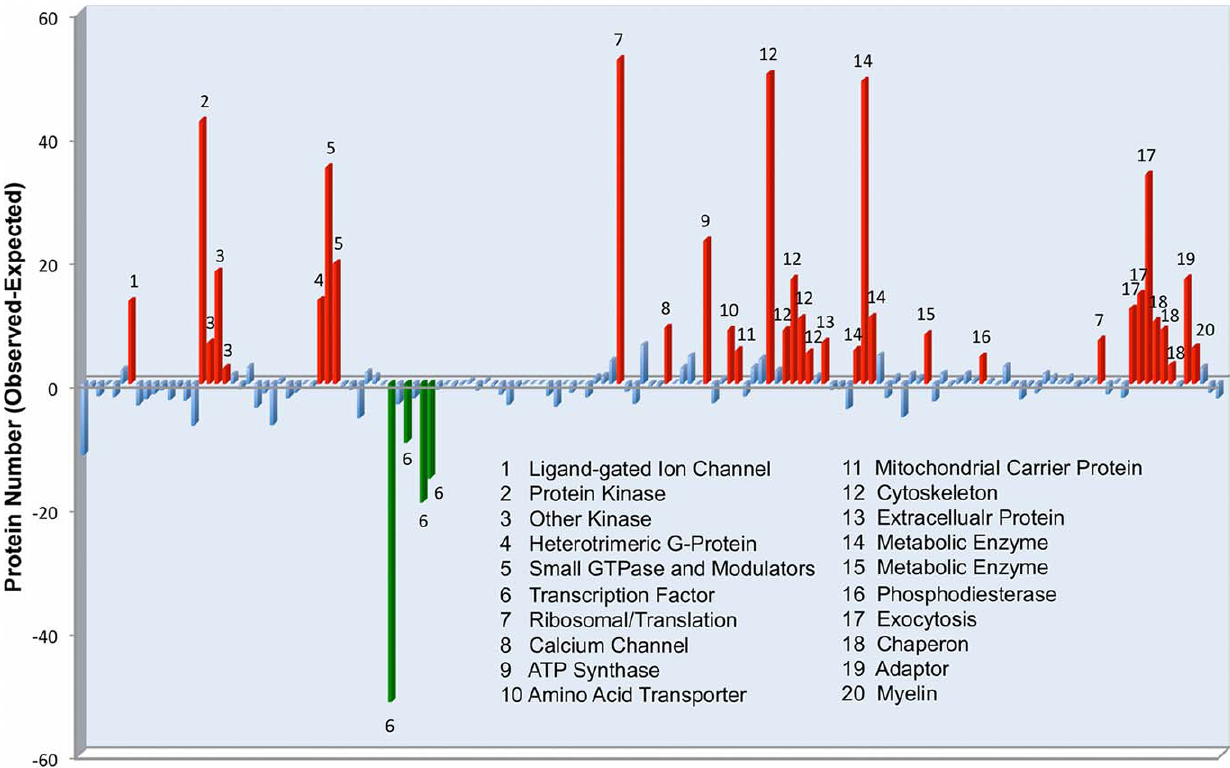
Figure 5. Functional protein groups with the mammalian cortical PSD. The mammalian cortical PSD was defined by combining all proteins identified in mouse and human. This set of PSD proteins were then functionally classified using the Panther Classification descriptor ‘Protein Class’. Enrichment analysis was done comparing the number of PSD proteins per class with the genome. The Panther Protein Class ontology is hierarchically organized, only end-branch classes are displayed to remove redundancy from the graph (all data in Table S8). Protein classes that did not show difference with the genome after correction for multiple testing are shown in blue. Classes overrepresented are shown in red and classes underrepresented are shown in